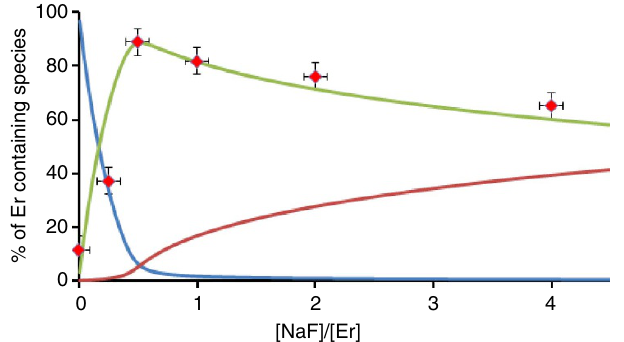
Figure 6 | Speciation in solution. The relative evolution of the percentages of the species present in solution ([ErL(D 2 O)] þ , blue; [(ErL) 2 F] þ , green; [ErLF], red) can be recalculated from the knowledge of the stability constants and were compared with UC emission intensity (integrated from 505 to 580nm, red squares) normalized on the concentration at 0.5 equivalent (errors correspond to those of a Poisson’s law for the intensity and to ± 5% for the relative concentrations). The speciation revealed a marked correlation between the UC intensity and the presence of the Er dimer.